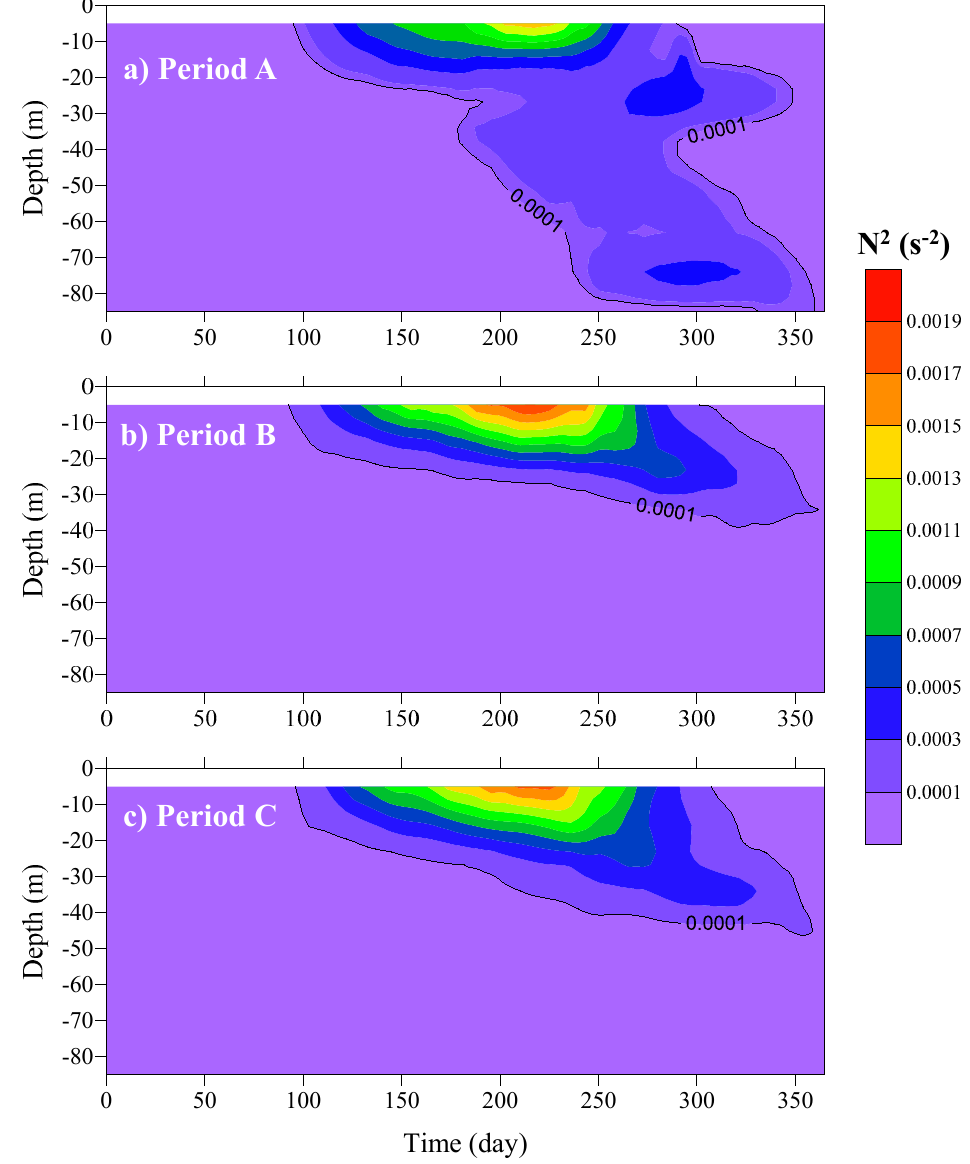
Figure 8. Contour plots of average N 2 for the three periods ( a – c ).